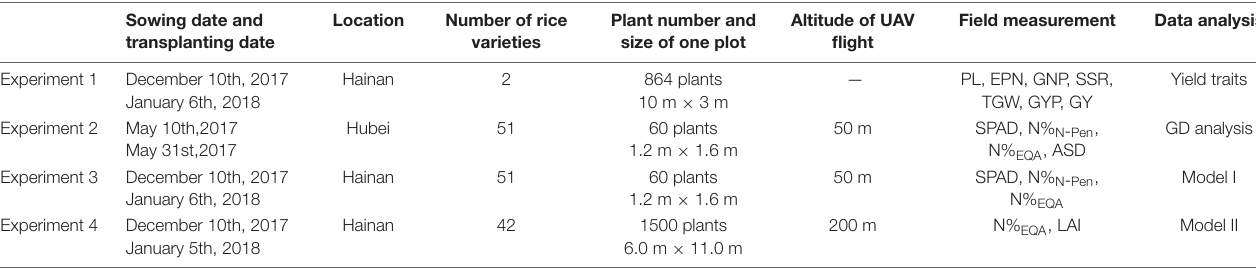
TABLE 1 | The details of the four experiments conducted in Hainan and Hubei from 2017 to